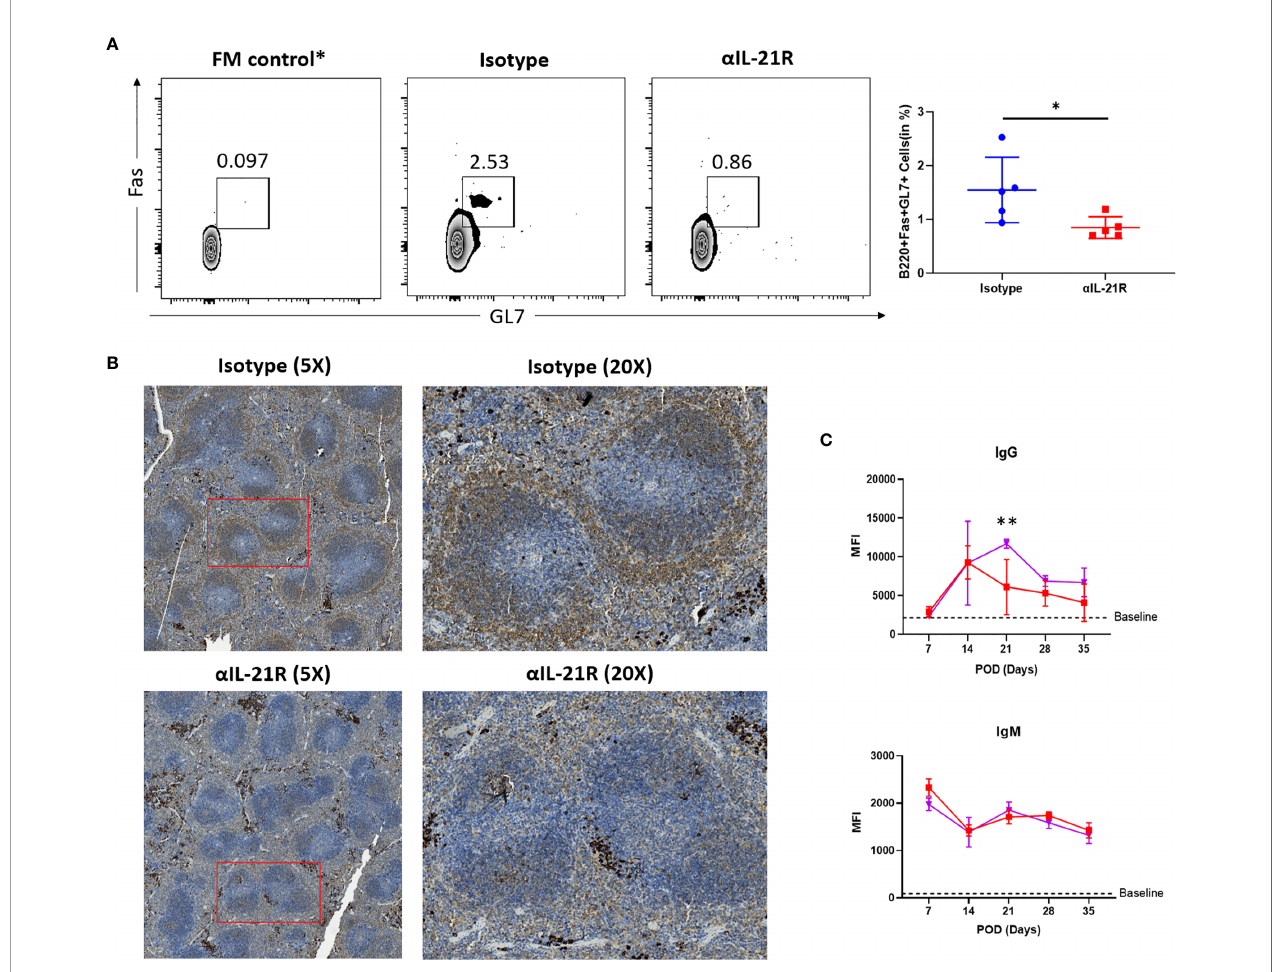
FIGURE 4 | GC reaction and dnDSA generation are blocked by a IL-21R. Skin allografts from BALB/c mice were transplanted onto C57BL/6 mice. Recipients were treated with 1 mg/kg a IL-21R three times every week or Isotype starting on the day of transplantation. (A) Frequencies of B220 + GL7 + Fas + GC B cells were assessed after 14 days by fl ow cytometry. (B) Spleens were harvest from recipients after 14 days of transplantation and stained with PNA. GC was identi fi ed as brown area in while pulp. (C) Serum was collected from recipients every week after transplantation. IgG and IgM level were detected with fl ow cytometry. Column plots display individual data points and mean ± SD, n = 5/group. *p<0.05,